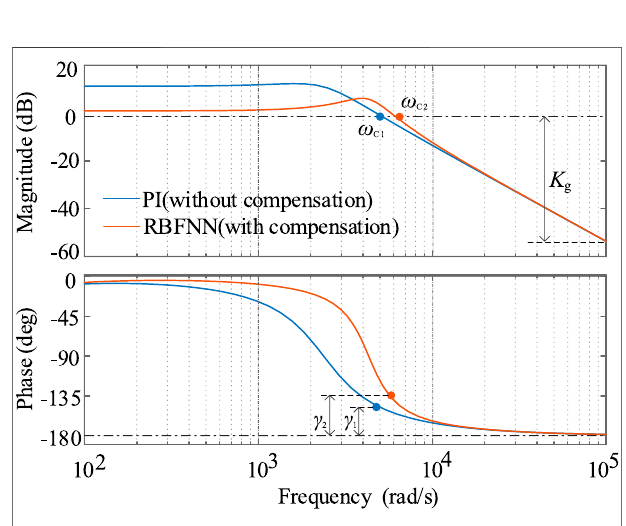
FIGURE 6 | Bode diagram of the DC converter closed loop